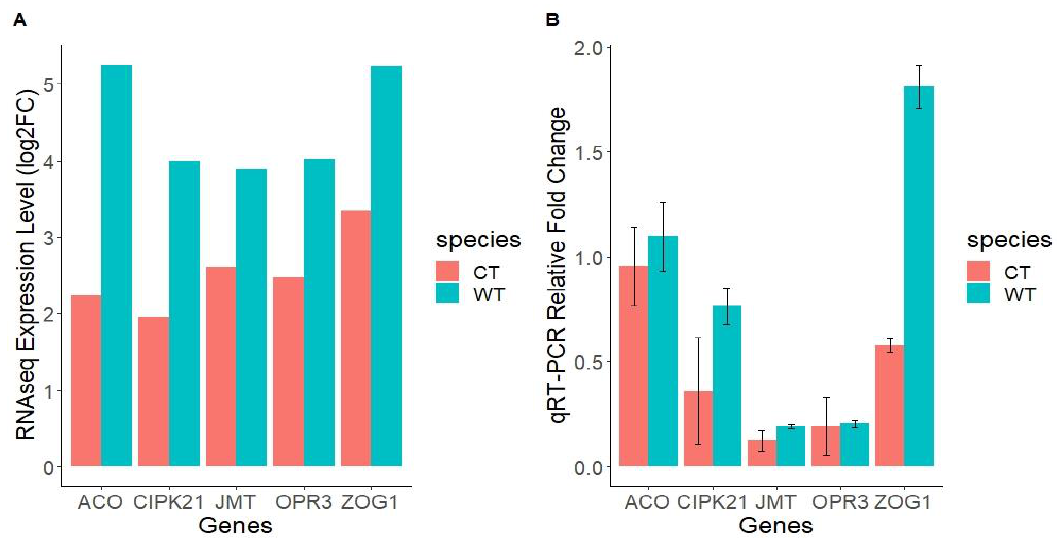
Figure 3. Comparative gene expression trends in cultivated susceptible KAT 60/8 (CT) and resistant wild (WT) genotypes pigeonpea Cajanus scarabaeoides accession IBS3471 from ( A ) RNAseq vs. ( B ) Real-time quantitative reverse transcription PCR (qRT-PCR) experiments. ACO: 1-aminocyclopropane-1-carboxylate oxidase, ZOG1: Zeatin O-glucosyltransferase- like, CIPK21: CBL-interacting serine/threonine-protein kinase 21, OPR3: 12-oxophytodienoate reductase 3-like and JMT: Jasmonate